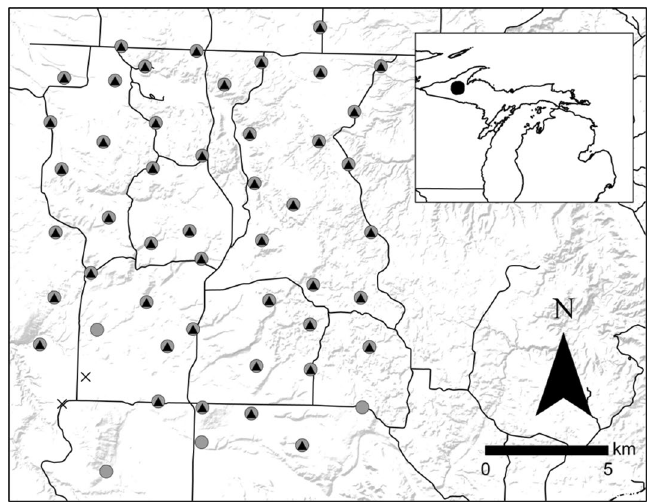
Figure 1. Carcass sites ( n = 52 ) used to monitor American marten and fisher activity and behavior in Upper Peninsula of Michigan, USA, January–March 2017–2019. Triangles represent sites with martens detected, circles represent sites with fishers detected, Xs represent sites with neither species detected, and black lines represent roads. Map generated using QGIS (QGIS Development Team 2020, version 2.14.20; available from http:// qgis. osgeo.